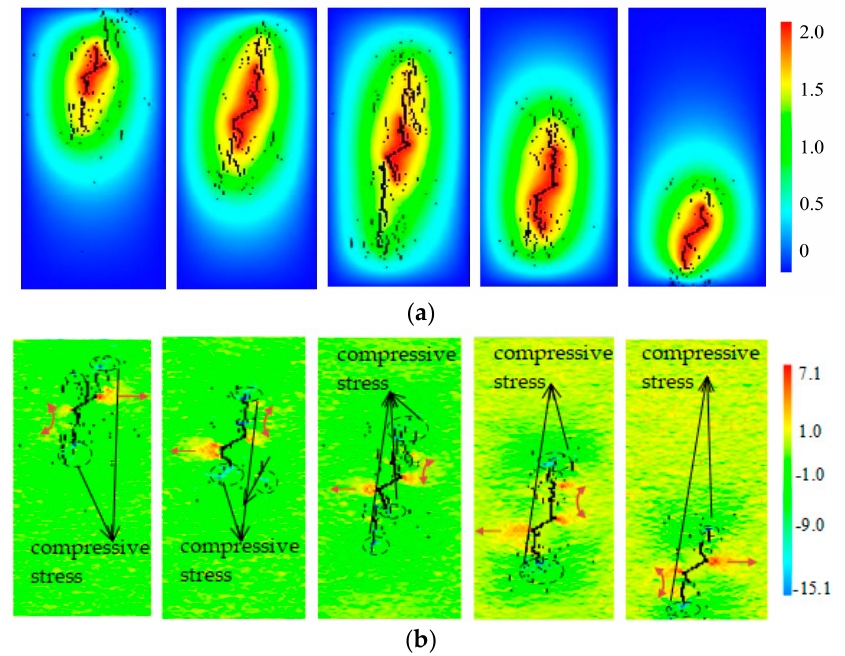
Figure 6. Distribution of water pressure and principal stress in crack propagation process with different joint locations with ( a ) water pressure diffusion during crack propagation, and ( b ) principal stress distribution during crack propagation.